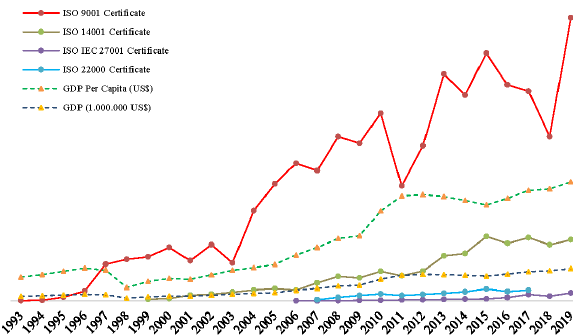
Figure 6: The growth of several certification systems compared to the value of GDP and GDP per capita in Indonesia